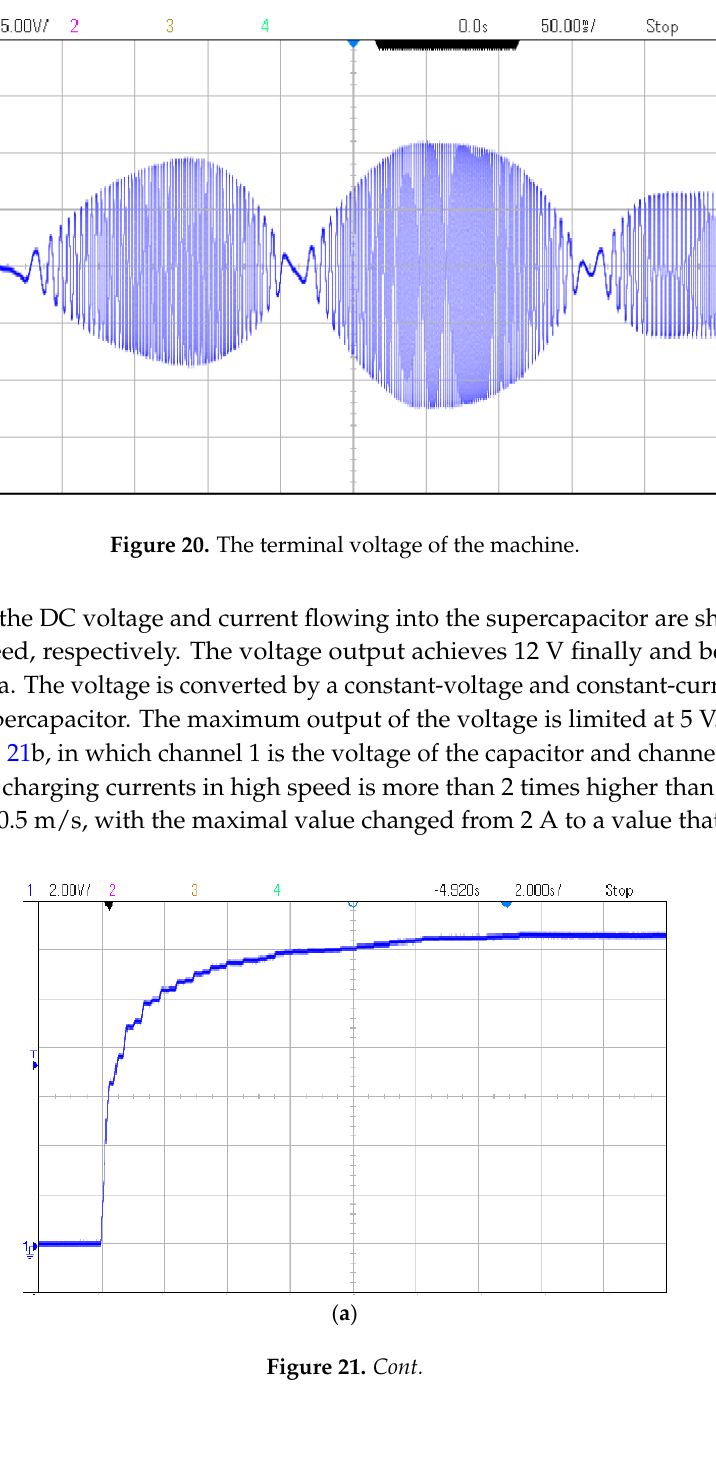
Figure 19. Experimental setup of the generation and energy storage system.